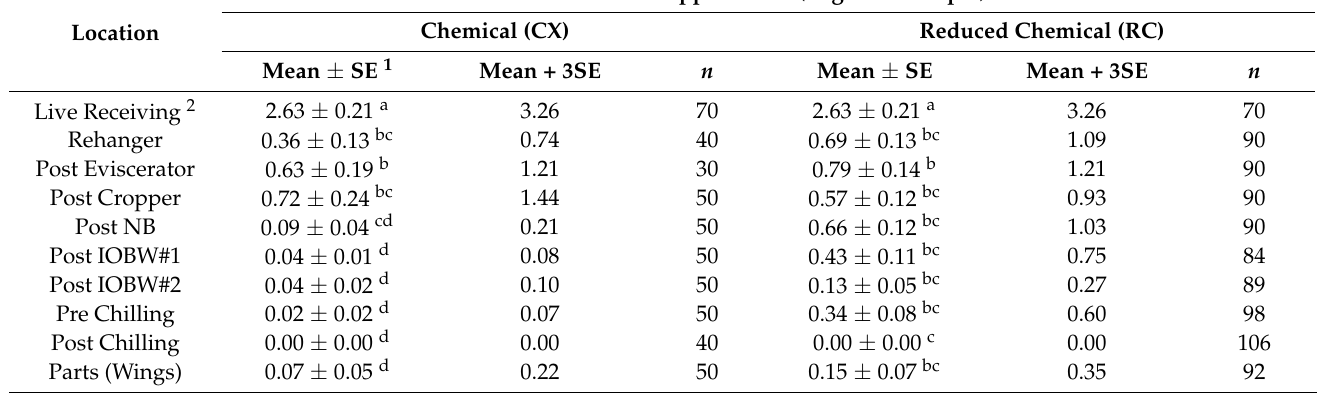
Table 4. Salmonella spp. counts (log CFU/sample) on each of the ten locations during the evisceration process under normal process interventions (CX) and low-chemical process interventions (RC) on chicken rinses.